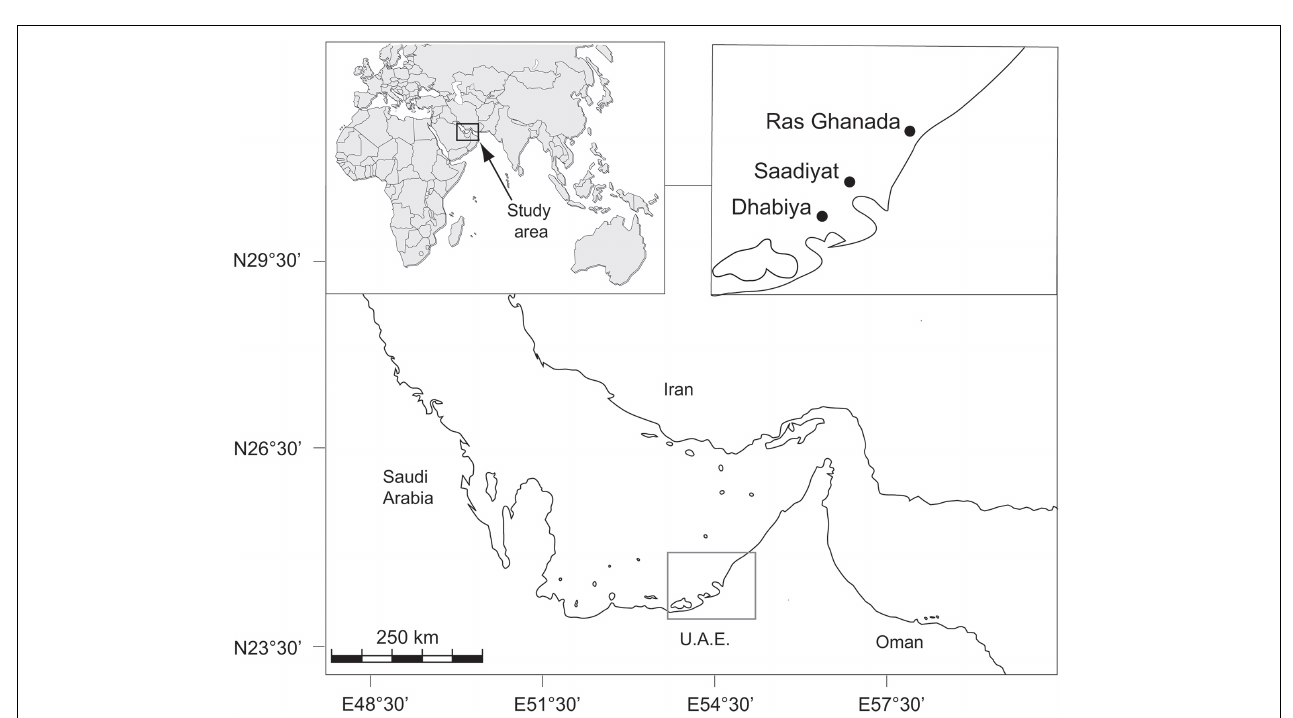
FIGURE 1 | Map of the location of the three coral reef sites investigated in this study.